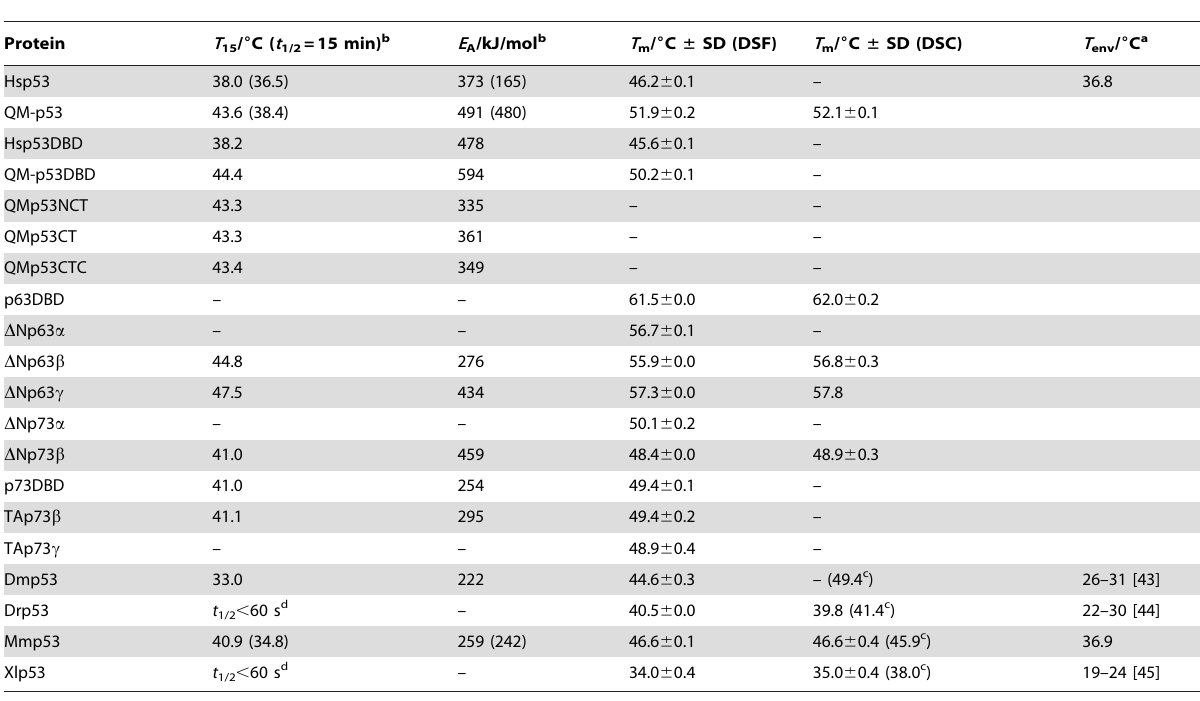
Table 1. Thermal and kinetic stability data for p53 family members.